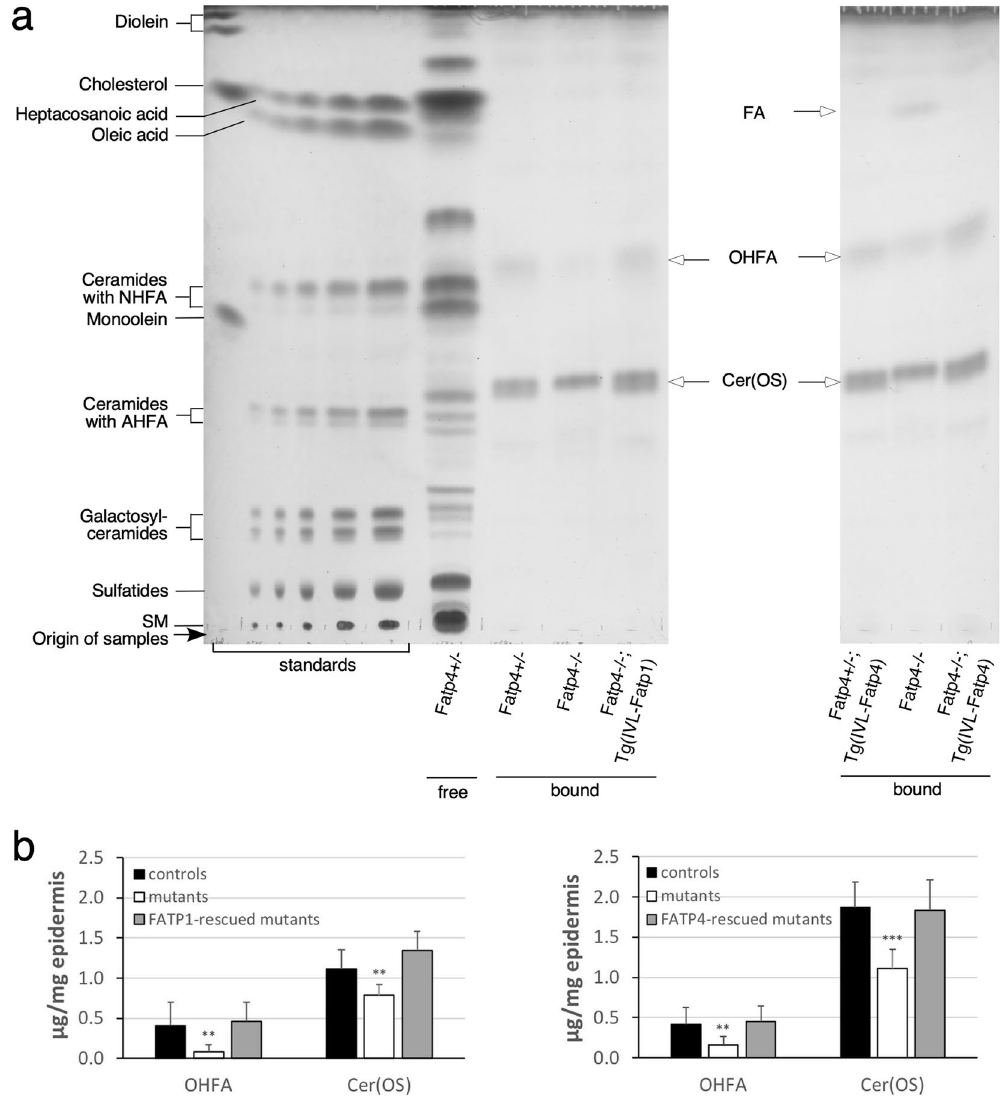
Figure 5. Alterations in the repertoire of protein-bound epidermal lipids in Fatp4 − / − mice. Protein-bound lipids from newborn mouse epidermis were co-resolved by TLC with standards and free epidermal lipids ( a ) and quantified in µ g per mg of dry epidermis ( b ). The decreased levels of OHFA and Cer(OS) seen in Fatp4 − / − mice were normalized by the Fatp1 ( Fatp4 − / − ; Tg(IVL-Fatp1) in a , left; b , left) and Fatp4 ( Fatp4 − / − ; Tg(IVL- Fatp4) in a , right; b , right) transgenes. A faster migrating FA band was seen in some Fatp4 − / − samples. Lipid standards ( a , left) and protein-bound epidermal lipids (arrows) are indicated. Quantification data ( b ) were obtained from two separate studies with standard deviation and statistical significance indicated ( ** P < 0.01; *** P < 0.001). Each study contained 6 each of control, Fatp4 − / − , and transgene-rescued mutant mice. The TLC results shown in a are from two separate TLC experiments; full vertical lengths are shown. IVL, involucrin